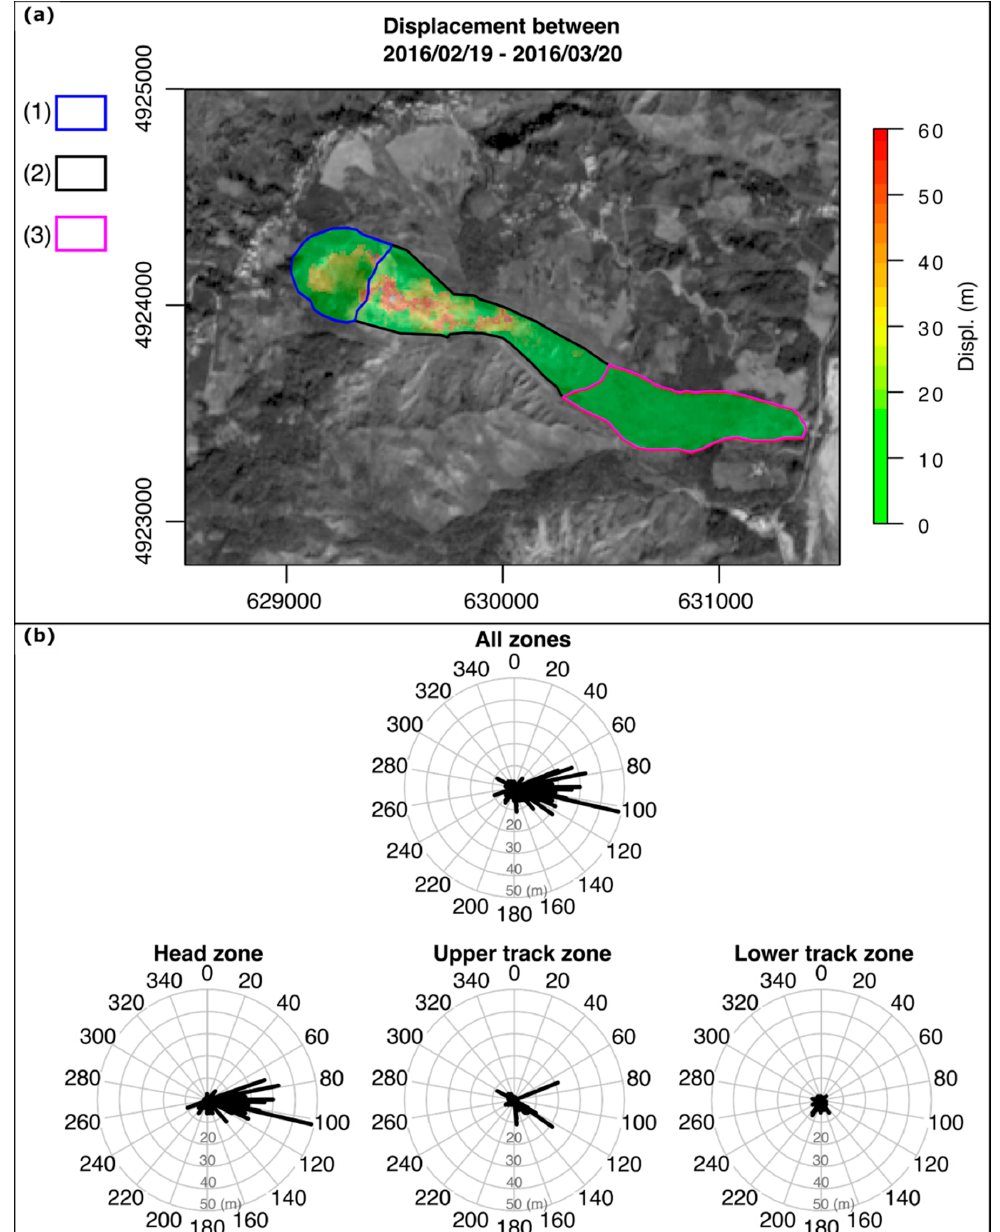
Figure 6. Displacement obtained by means of the DIC analysis between Sentinel-2 scenes acquired on 19/02/2016 and 20/03/2016. ( a ) DIC displ modules within the active landslide area. (1) Head zone; (2) Upper track zone; (3) Lower track zone. ( b ) Displacement module and geographic direction for all the active landslides (up) and according to the respective geomorphic zone (down). Grid coordinates: WGS84 / UTM32N (EPSG: 32632).